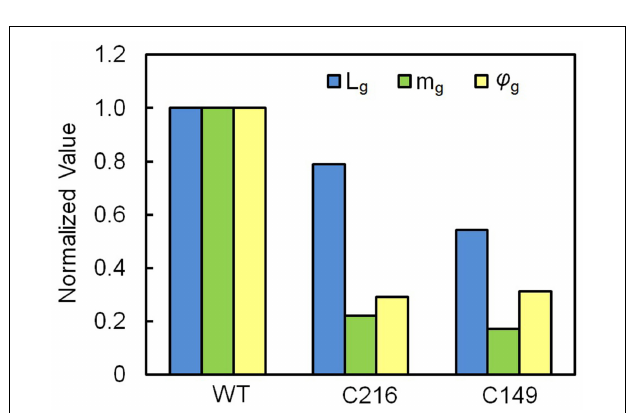
FIGURE 6 | Normalized values of Lg, mg, and φ g for wild type (WT) and stiff mutant strain (C216 and C149) stage IVb sporangiophores . Normalized values for each variable are obtained by dividing the average values presented in Table 1 forWT and stiff mutant (C216 and C149) stage IVb sporangiophores by the largest magnitude of the respective variable. The magnitudes of L g (blue bar), m g (green bar), and φ g (yellow bar) for stiff mutant sporangiophores (C216 and C149) are smaller compare to respective magnitudes